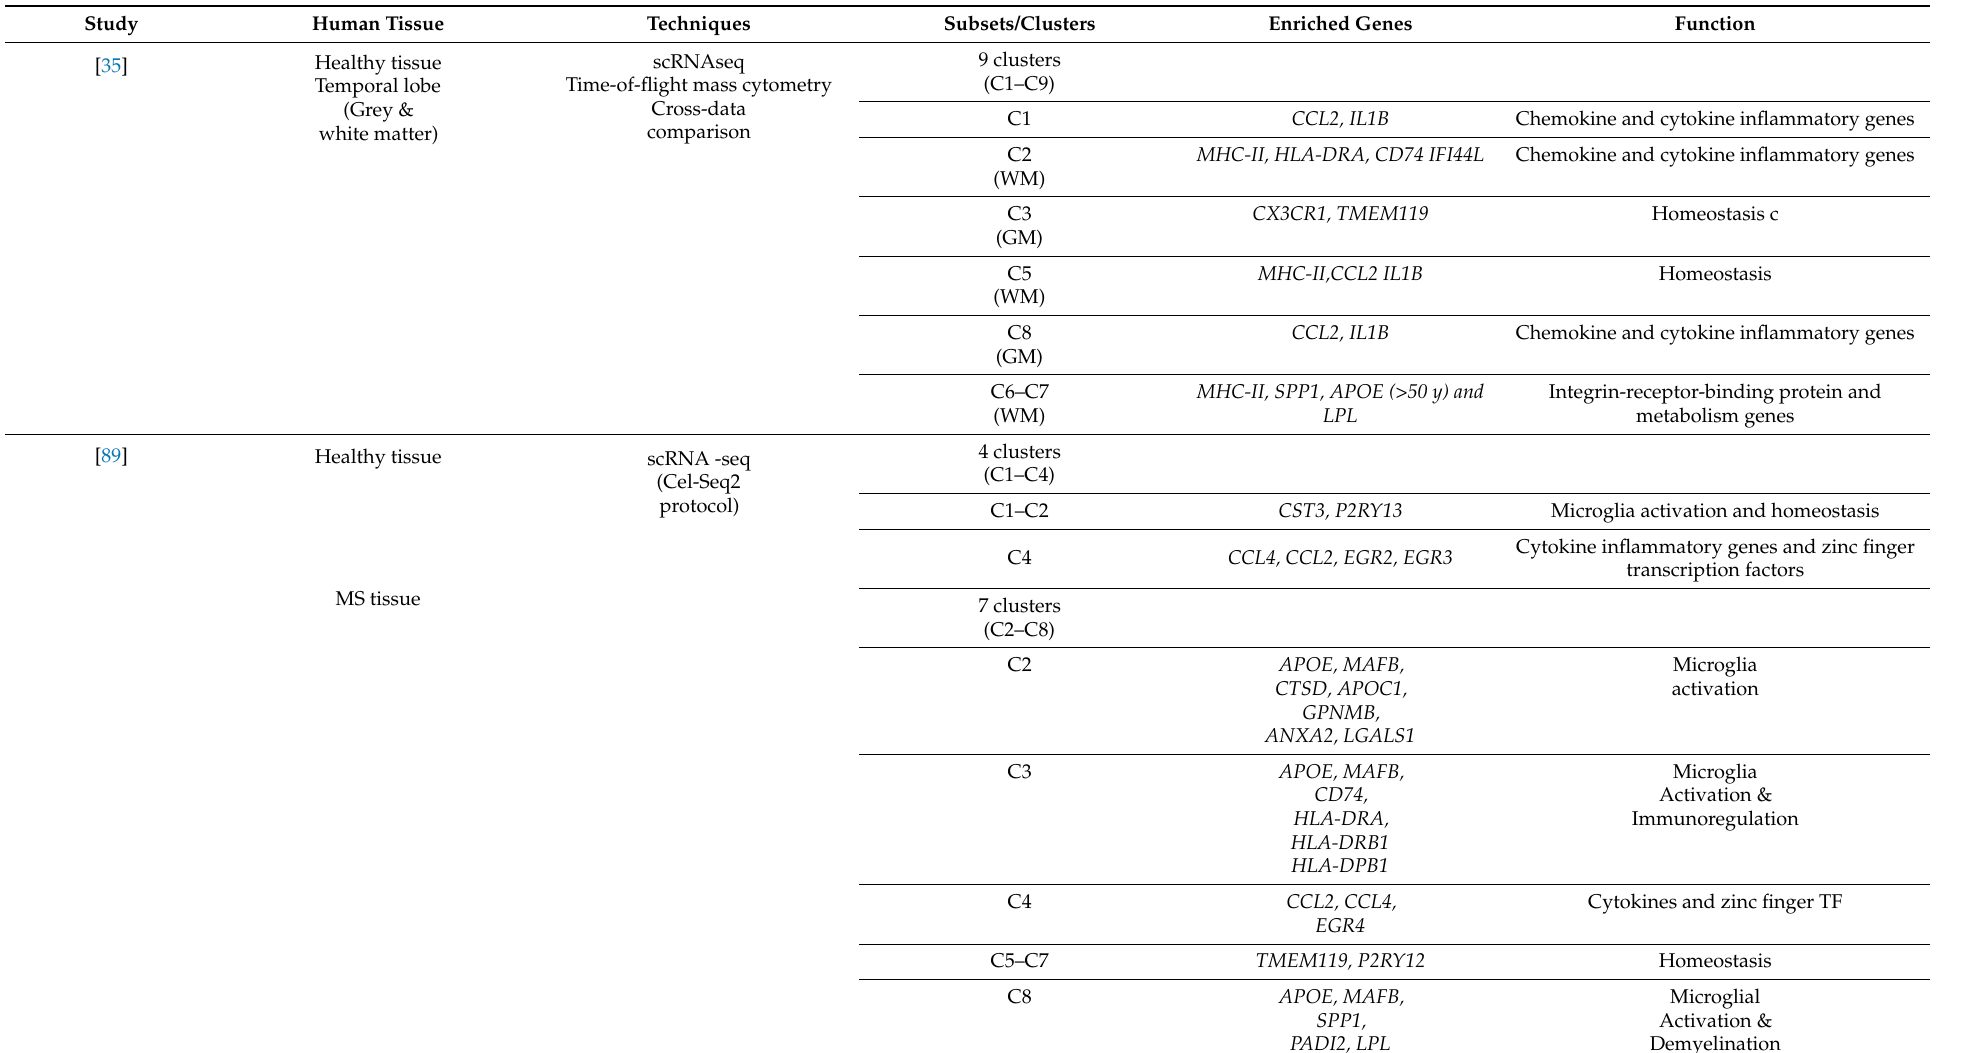
Table 1. Human gene signatures of microglia subsets in healthy and diseased brain. Microglia clusters identified by the expression of core